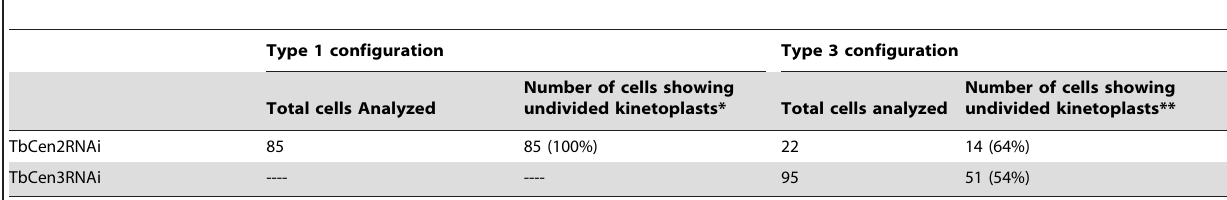
Table 1. T. brucei procyclic cells after TbCen2 or 3 RNAi induction displaying the cell populations that contain undivided kinetoplasts.